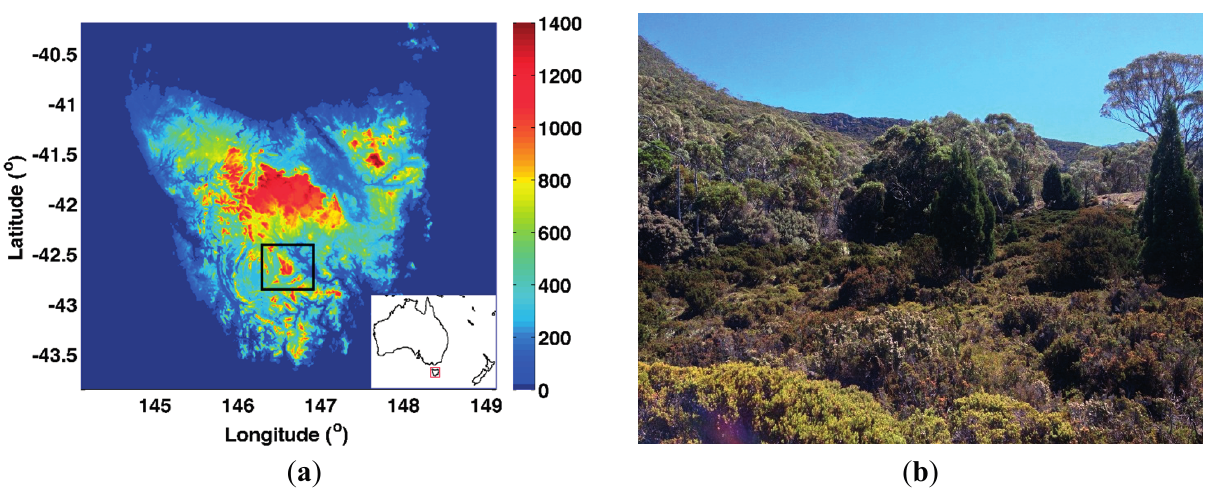
Figure 1. ( a ) Elevation map of the Mt Field study area in south central Tasmania, with inset of Australia; ( b ) Dense vegetation and variable terrain were characteristic of our study